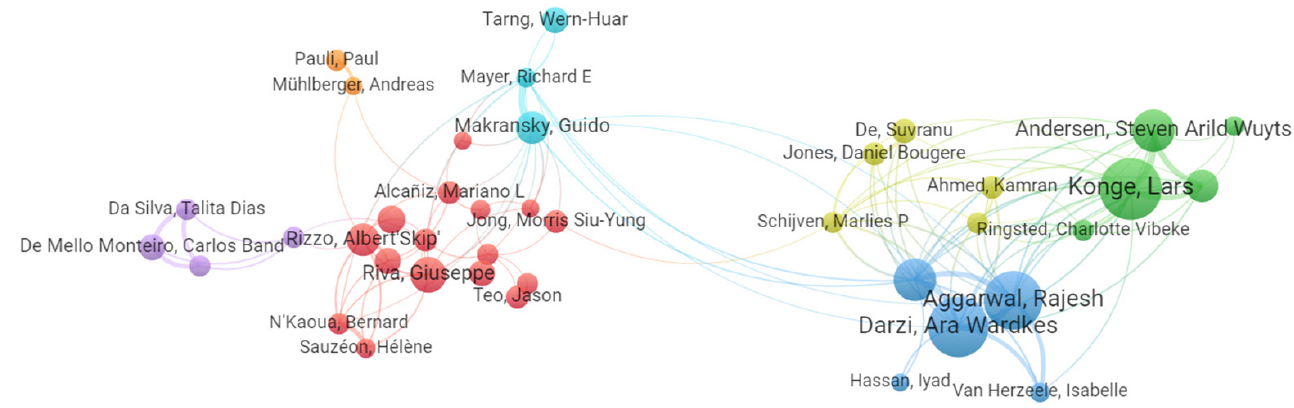
Fig. 12. Top authors with most publications: VR for learning